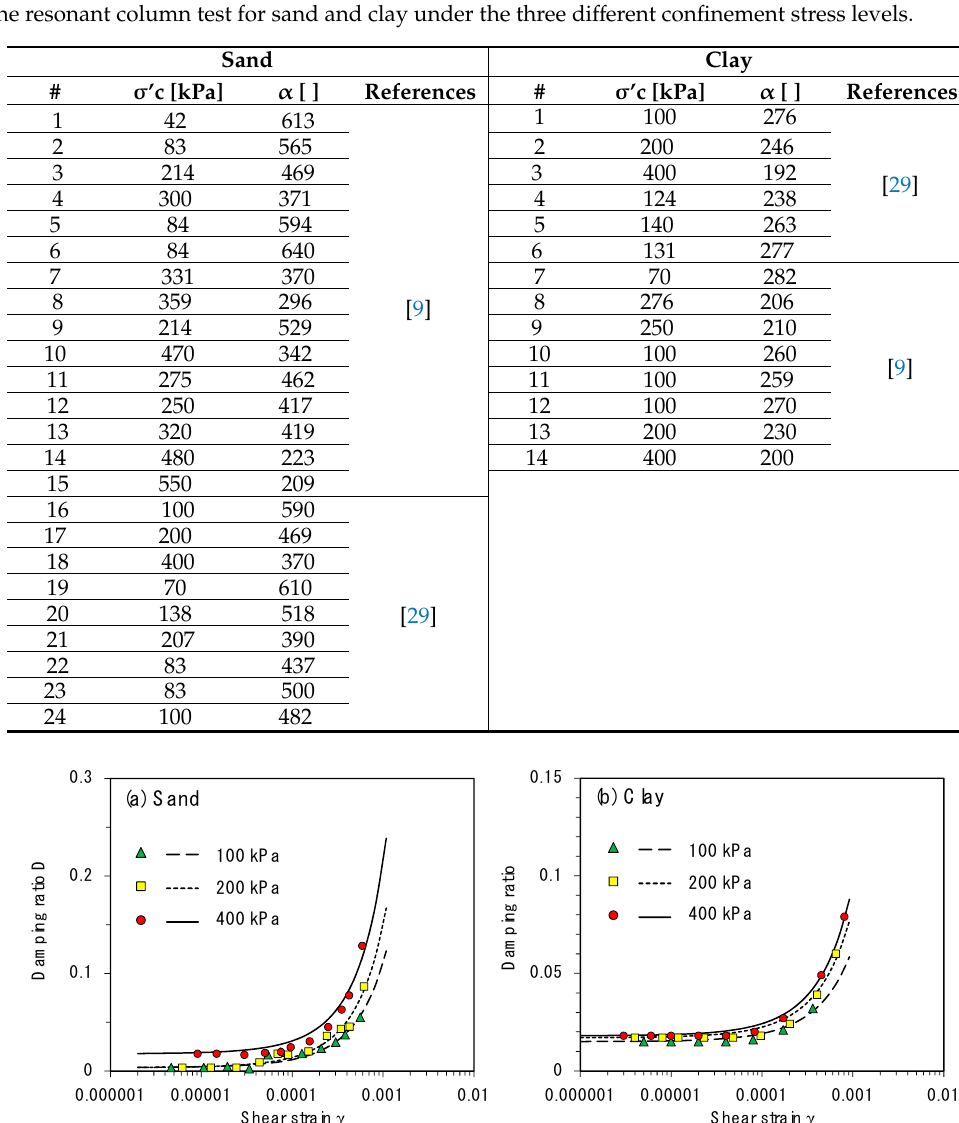
Figure 3. Damping ratios of sand and clay under three different confinement stress levels (sand data from 16~18 and Clay data from 1 ~ 3 in Table 1): ( a ) Sand; ( b ) clay. The symbols are experimental data and the lines are defined by Equations (7) and (10).